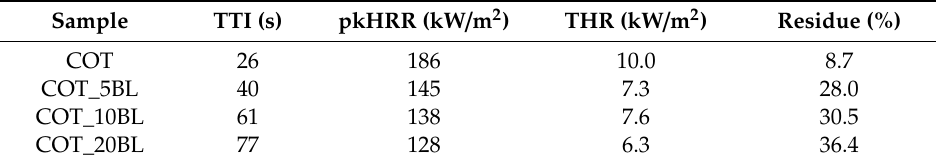
Table 21. Cone calorimetry data of the untreated and LbL-treated cotton